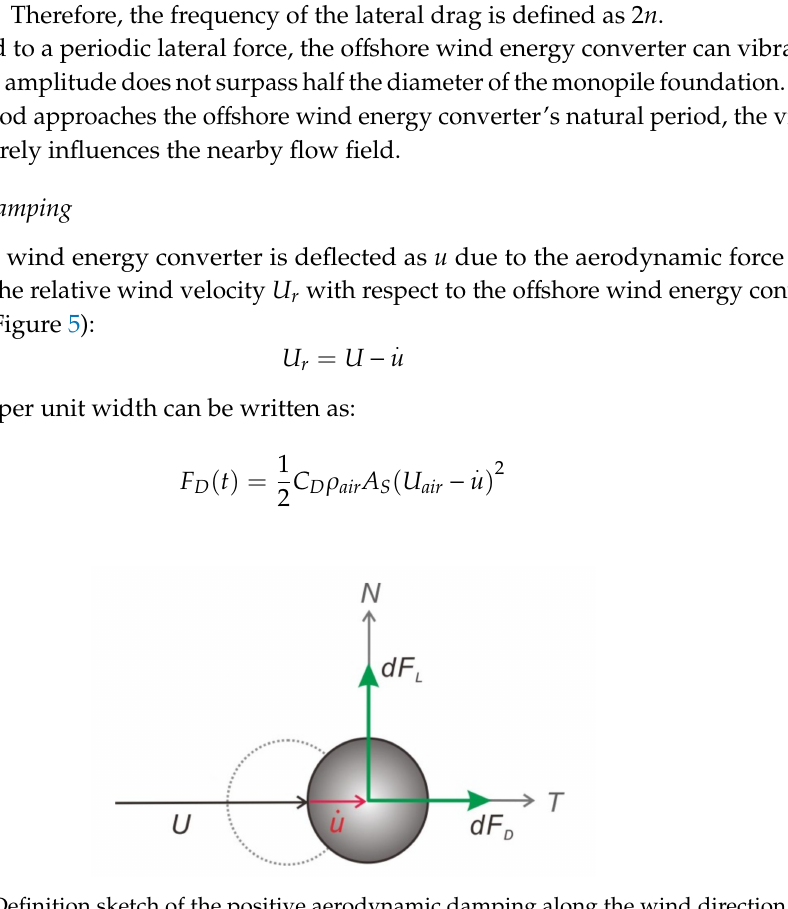
Figure 5. Definition sketch of the positive aerodynamic damping along the wind